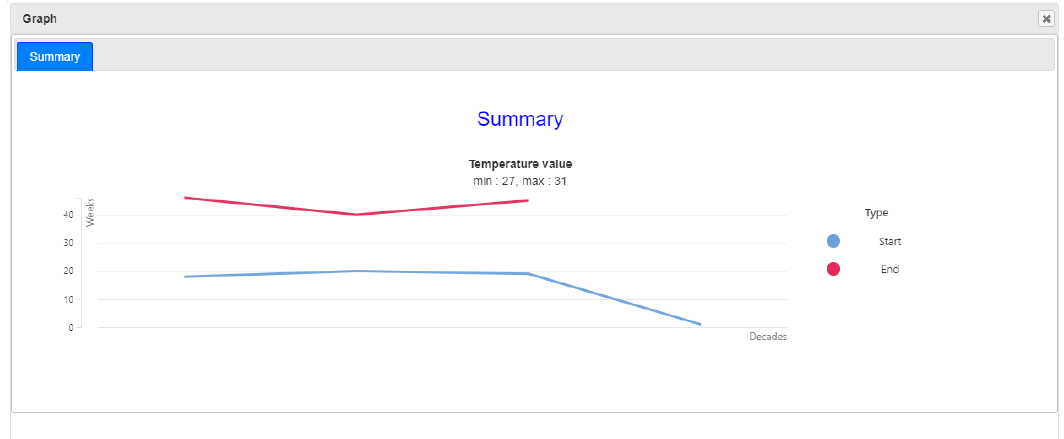
Figure 11. Evolution of periods for which MAX ( temp ) ≥ 27 ◦ C and MAX ( temp ) ≤ 31 ◦ C on a given geographic area (simulation).